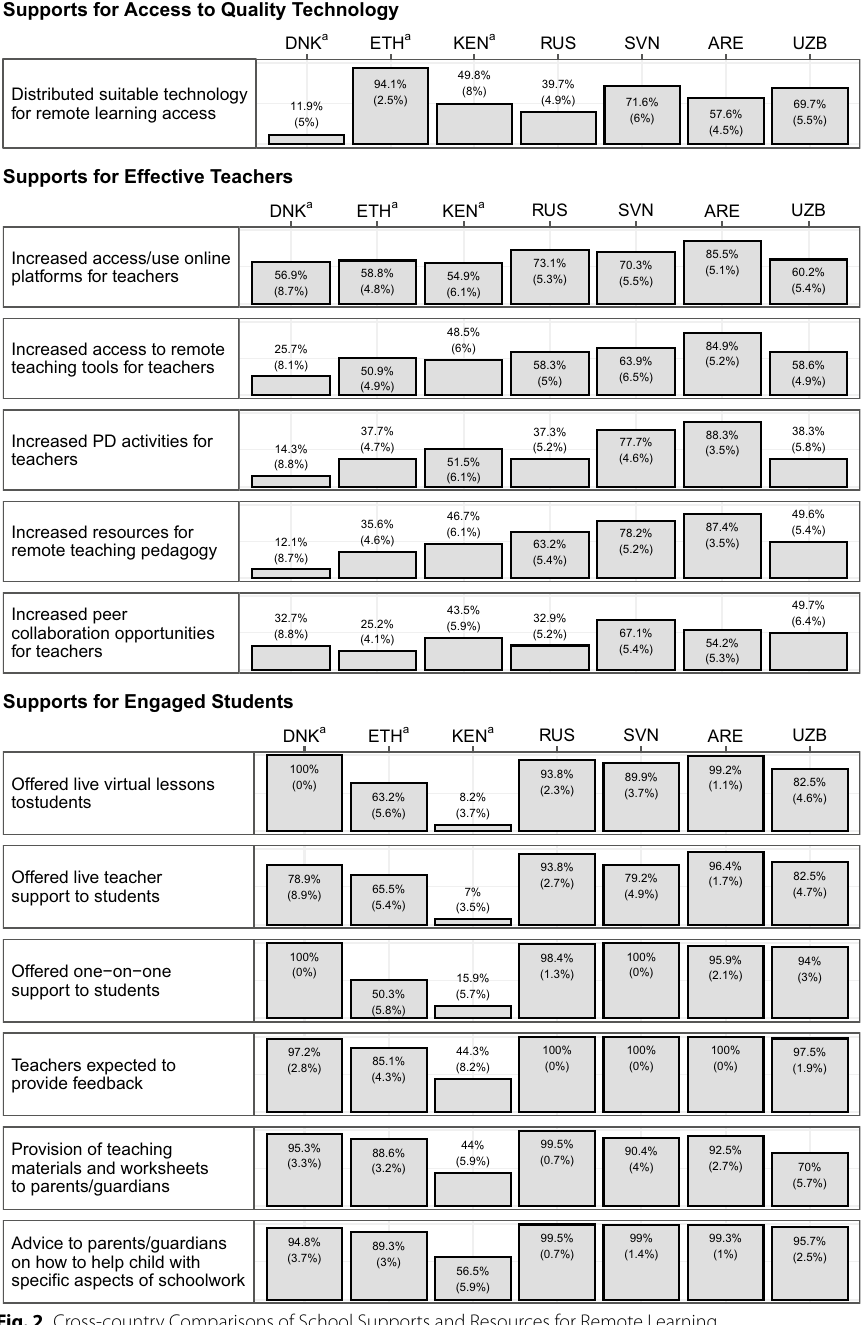
Fig. 2 Cross‑country Comparisons of School Supports and Resources for Remote Learning. a Data may not be representative of target population. Notes: Standard errors are presented in parentheses. Probability weights have been applied and jackknife standard errors are presented for all countries except in Denmark, Ethiopia, and Kenya. Standard errors reported for Denmark, Ethiopia, and Kenya account for clustering of observations within schools. DNK Denmark, ETH Ethiopia, KEN Kenya, RUS Russian Federation, SVN Slovenia, ARE United Arab = = = = = = Emirates,